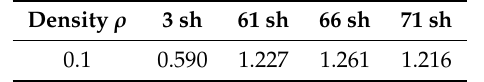
Table 1. Standard deviation for velocity and a selected number of speed humps